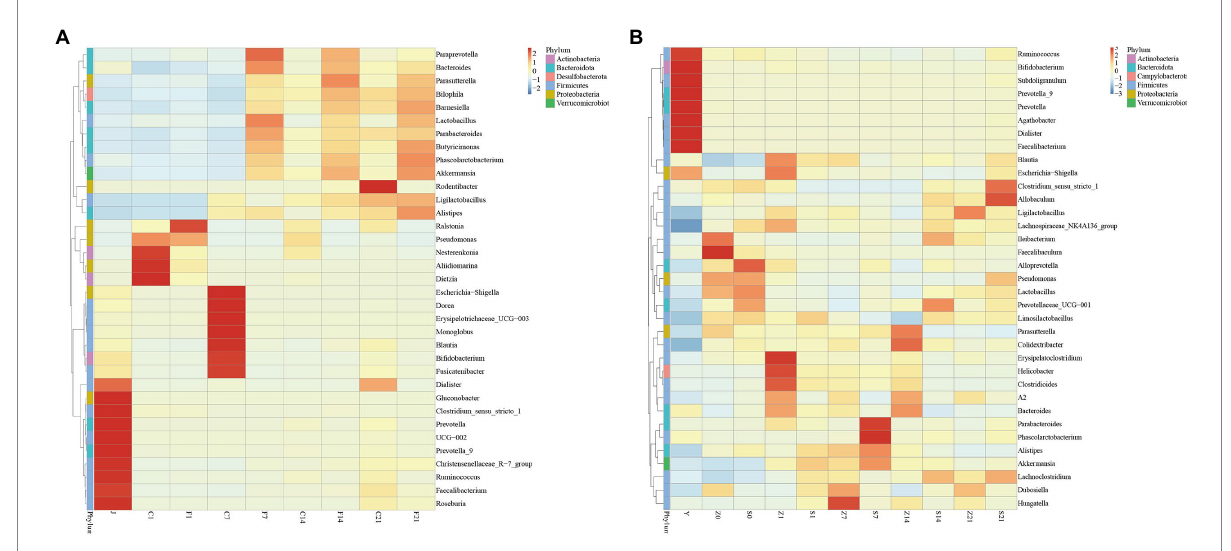
FIGURE 2 Heat map of relative abundance of gut microbial composition clustering at the genus level. (A) Heat map of relative abundance of gut microbial composition clustering at the genus level of GF mice; J, human-derived mixed gestational fecal fluid; C, control arm; F, FMT arm; (B) Heat map